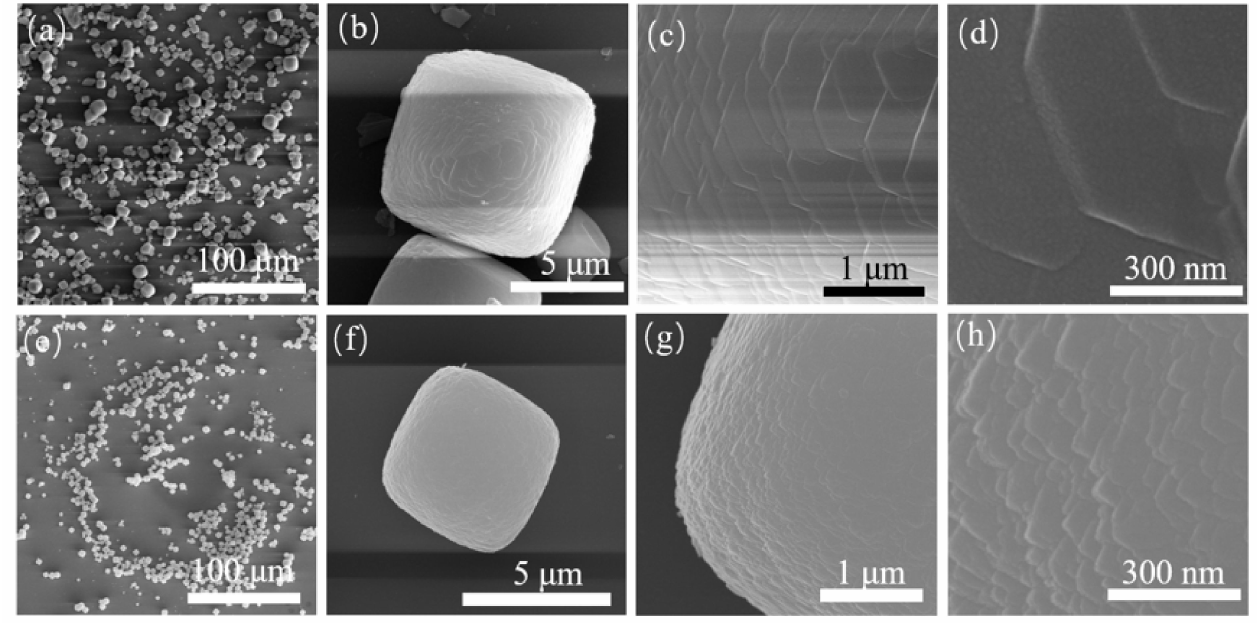
Figure 3. SEM diagrams of S-5 ( a – d ) and S-6 ( e – h ).